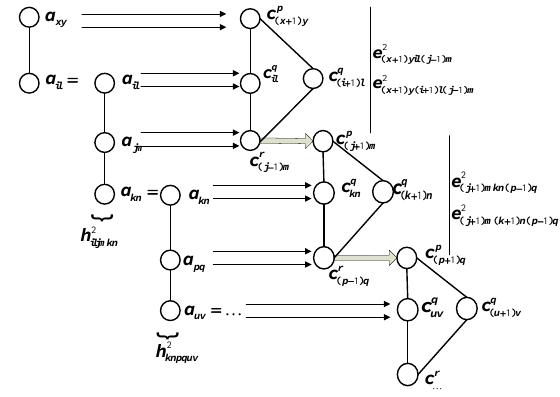
Fig. 4. Mapping of ternary relations or elementary schemes